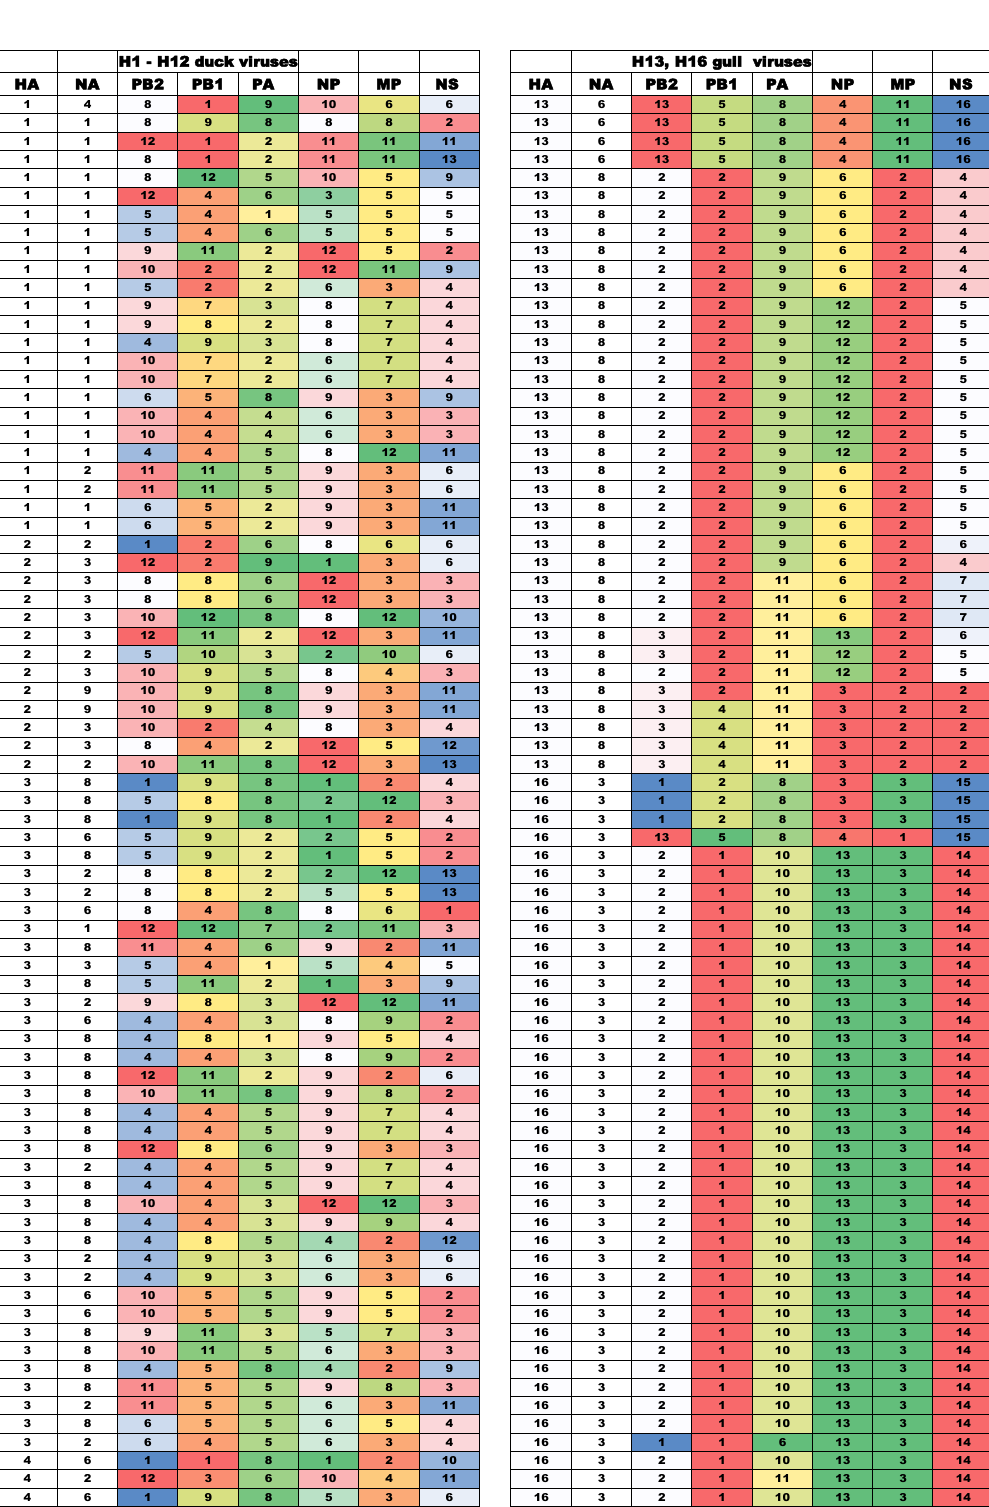
Figure 1. Genome constellations of IAVs isolated from ducks and gulls in The Netherlands in 2007–2009 (colors in each column depict clades of the indicated gene segment on the phylogenetic tree (see Tables S2–S4 of Supplementary Materials). The names of the strains are not shown in the figure for clarity, they are shown in the Tables S2–S5 of Supplementary Materials).